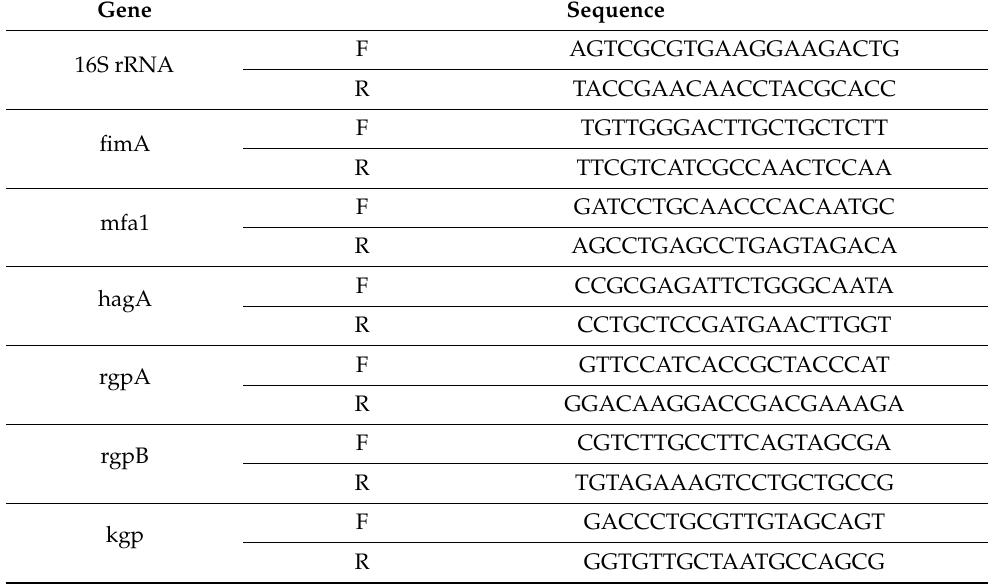
Table 1. The sequence of primers used in this study.